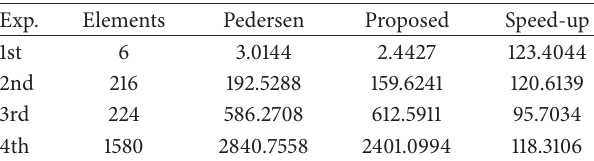
Table 10: Computation times (s) of system solutions (Pedersen: Pedersen’s nonlinear FEM; Proposed: proposed nonlinear FEM; and Speed-up: relative performance comparison of the proposed nonlinear FEM method with Pedersen’s nonlinear FEM method using single thread).